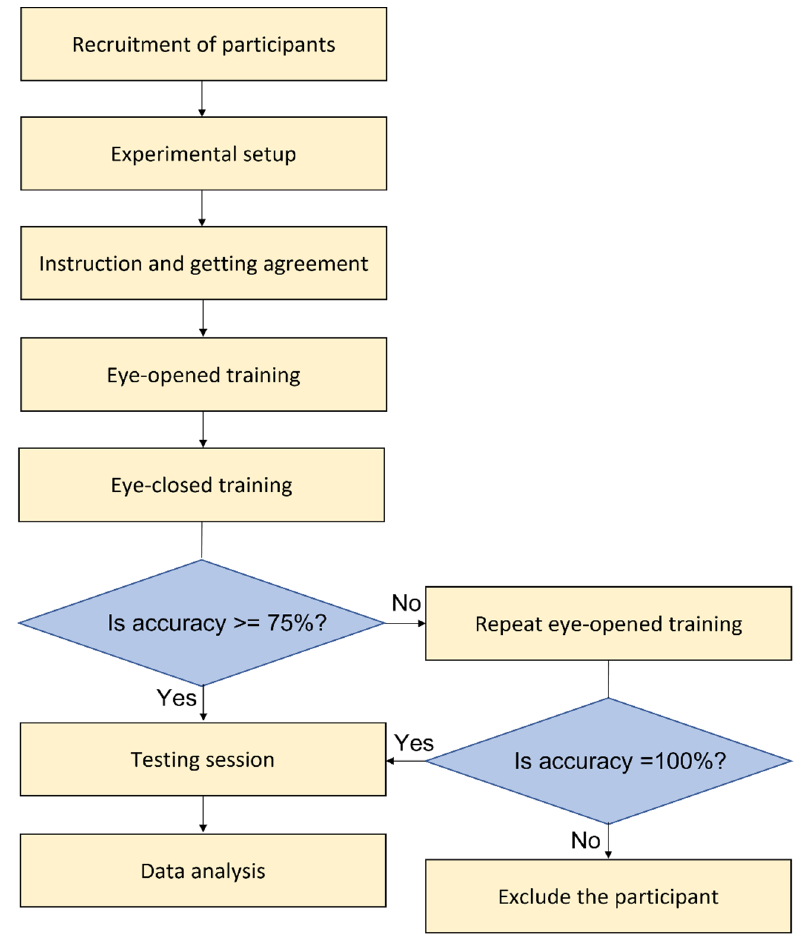
Figure 1. Flowchart of the experimental